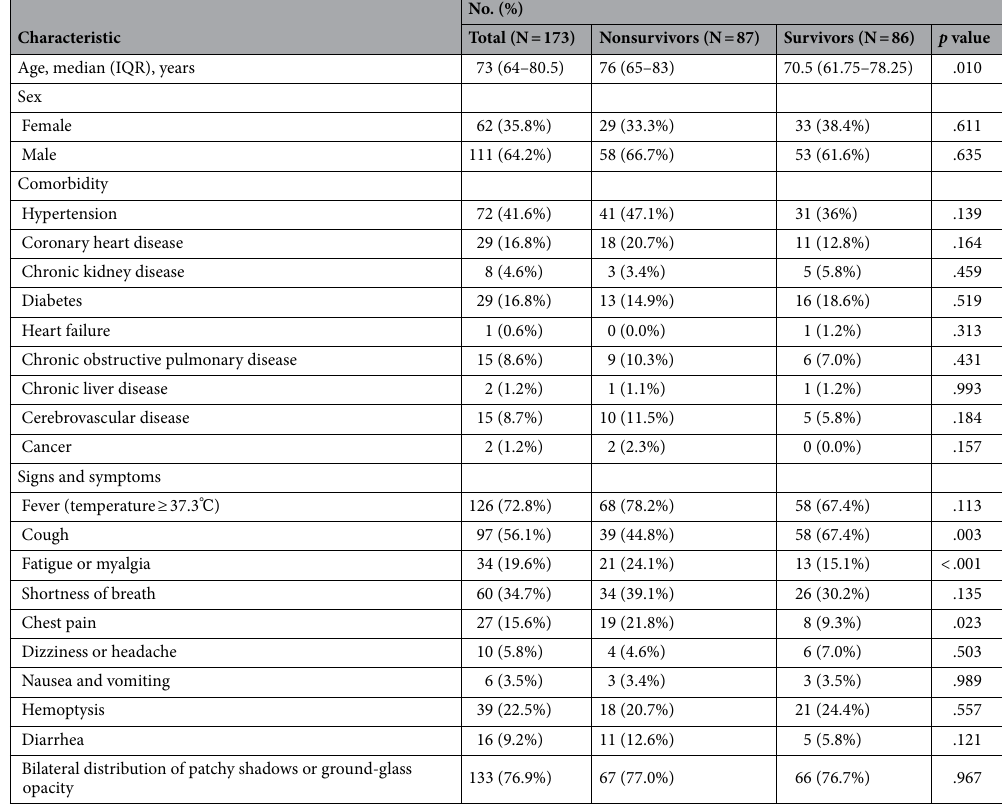
Table 1. Demographics and baseline characteristics of COVID-19 patients with cardiac